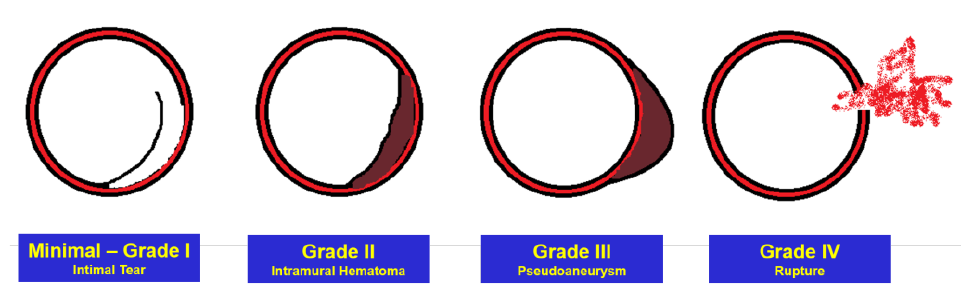
Figure 3. Grade of aortic injuries.